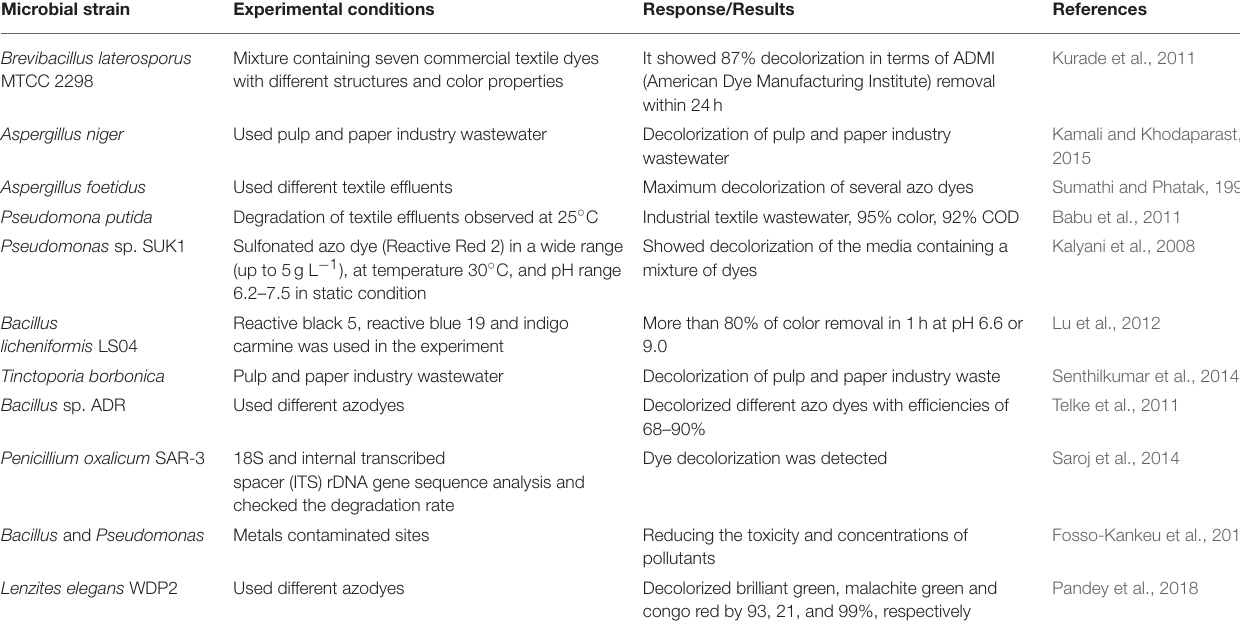
TABLE 2 | Potential of microbial strains for detoxification of industrial